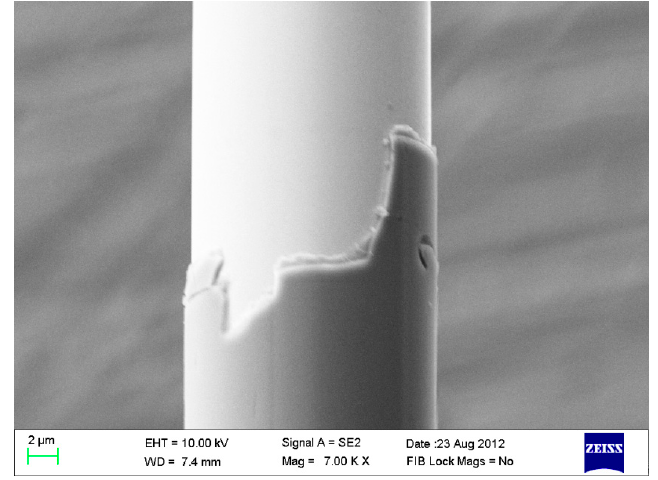
Figure 4. Scanning electron microscopy (SEM) micrographs of the glass–coated fibers ( x = 2).